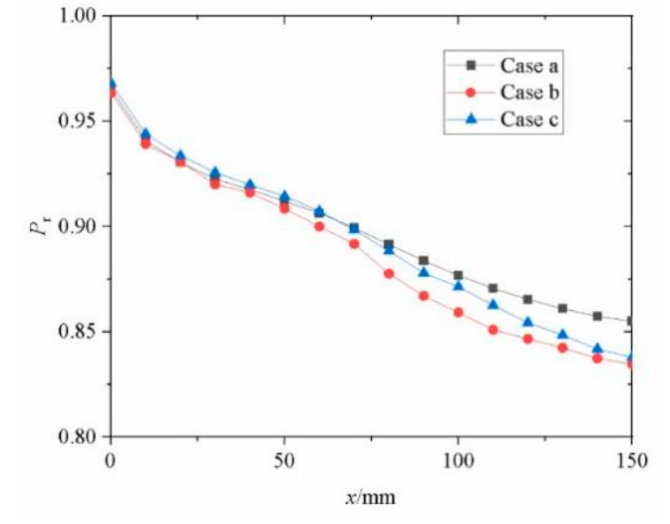
Figure 18. Total pressure recovery coefficient curves for Case a, Case b, and Case